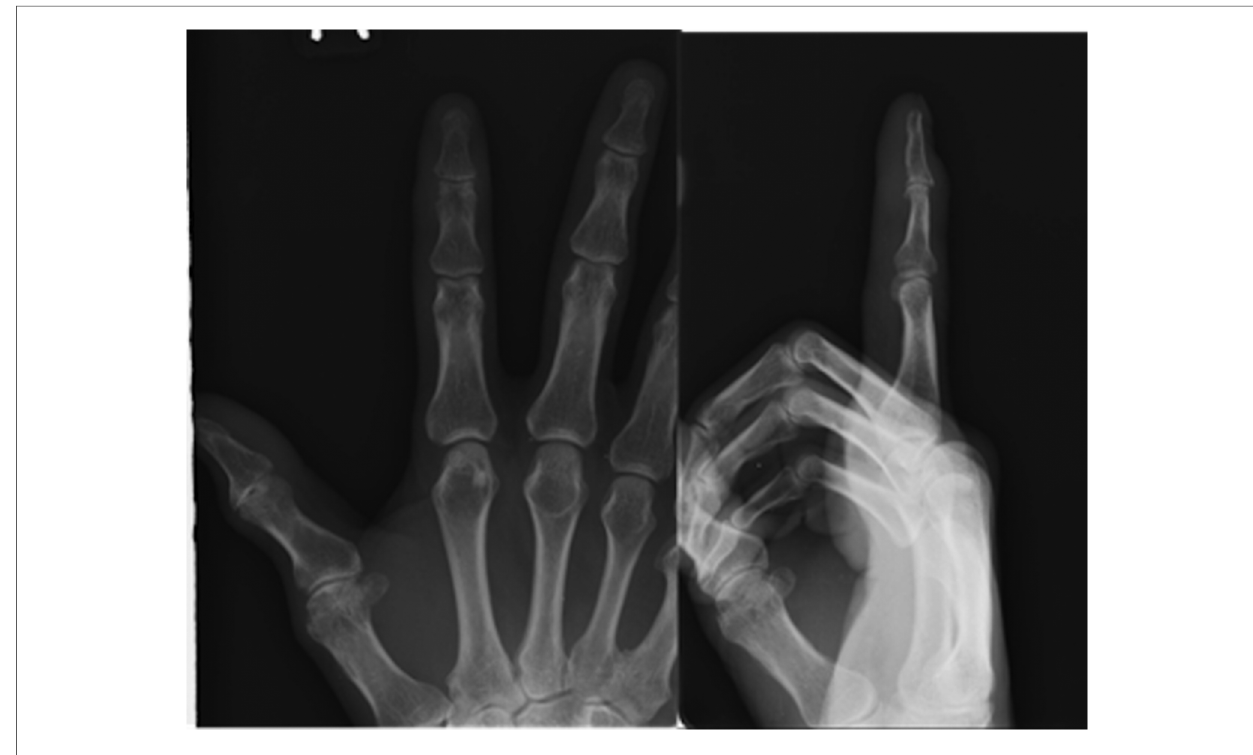
FIGURE 5 Postoperative x-ray depicting no residual calci fi